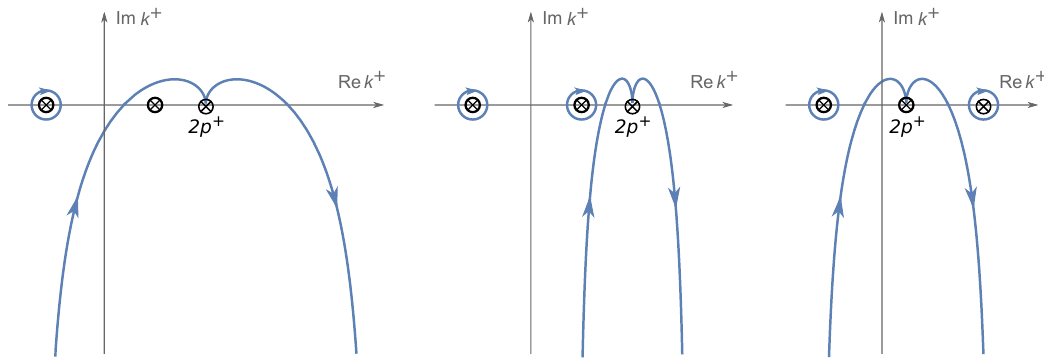
q p 2 . These 3 (cid:12)gures show all 2 p + p (cid:0)